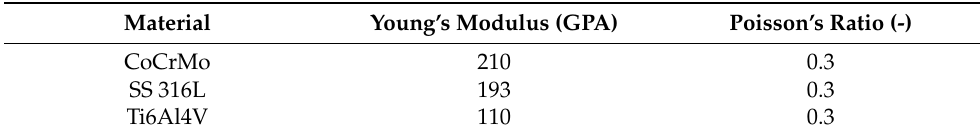
Table 2. Material properties for metallic